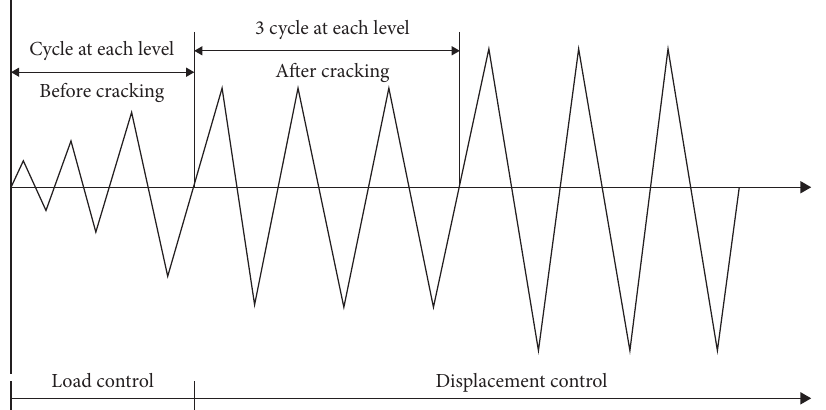
Figure 5: Loading